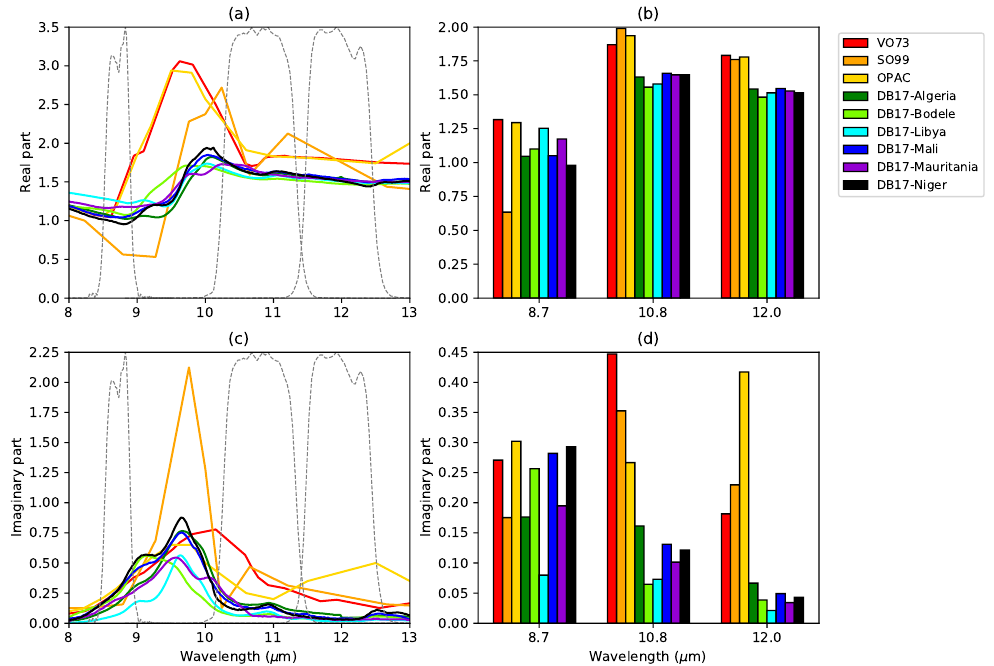
Figure 4. Plots of the real (a, b) and imaginary (c, d) parts of the dust refractive index, for nine of the dust databases considered in this study. For the left panels (a, c) the refractive indices are shown as a function of wavelength, as specified by their databases; the grey dashed lines indicate the relevant MSG-3 SEVIRI filter functions, normalized to the scale of the y -axis. For the right panels (b, d) the refractive indices have been convolved across these MSG-3 SEVIRI filter